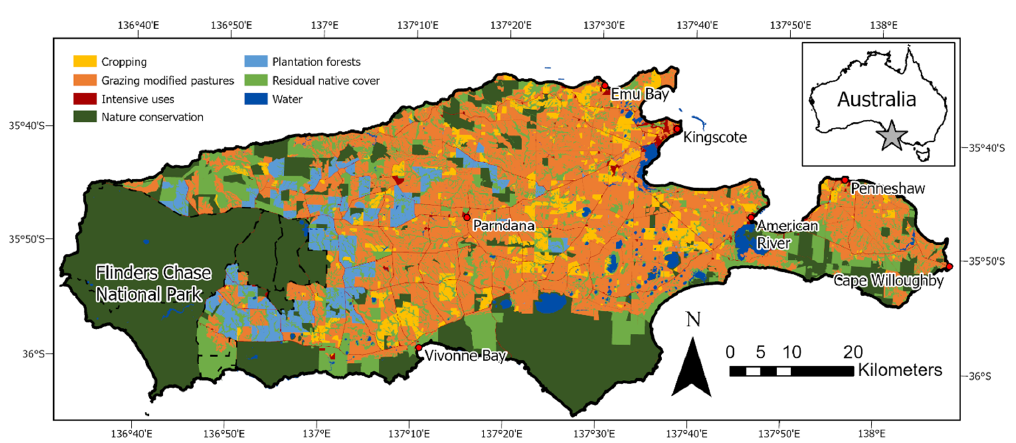
Figure 1. Kangaroo Island, Australia. Land use classes based on the Australian Land Use and Management Classification V8 [43]. Population centres and other points of interest shown. Flinders Chase NP (and the associated Ravine Des Casoars Wilderness Protection Area) shown with a dashed black outline [44].